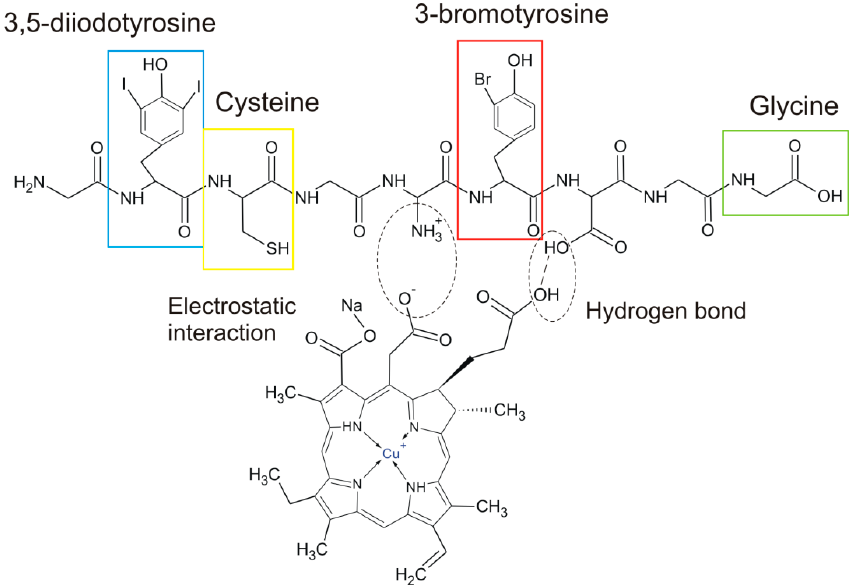
Figure 7. Proposed mechanism of interaction between SCC and spongin-based sponge skeletons (typical spongin-build amino acids are marked in frames).